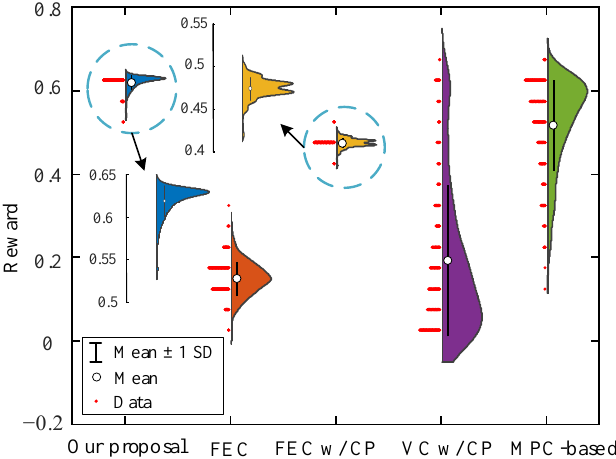
Figure 9. Distribution of episode reward achieved based on test dataset for different strategies.